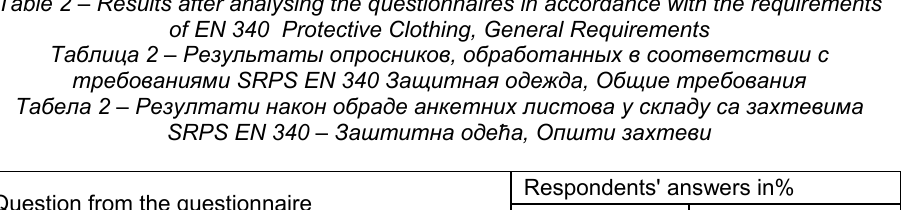
Table 2 – Results after analysing the questionnaires in accordance with the requirements of EN 340 Protective Clothing, General